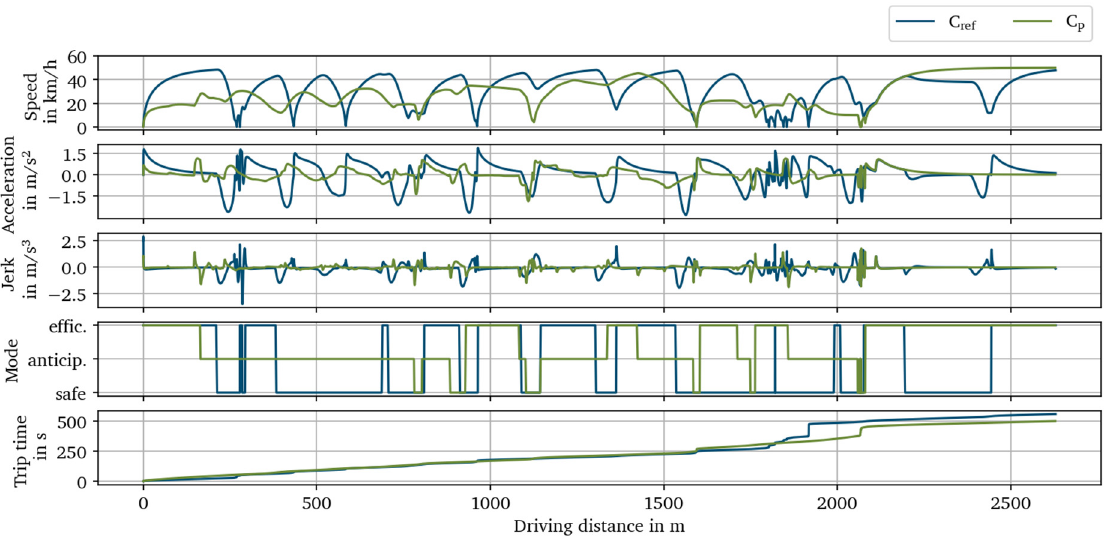
Figure 13. Exemplary results for C ref and C p on Route 5.